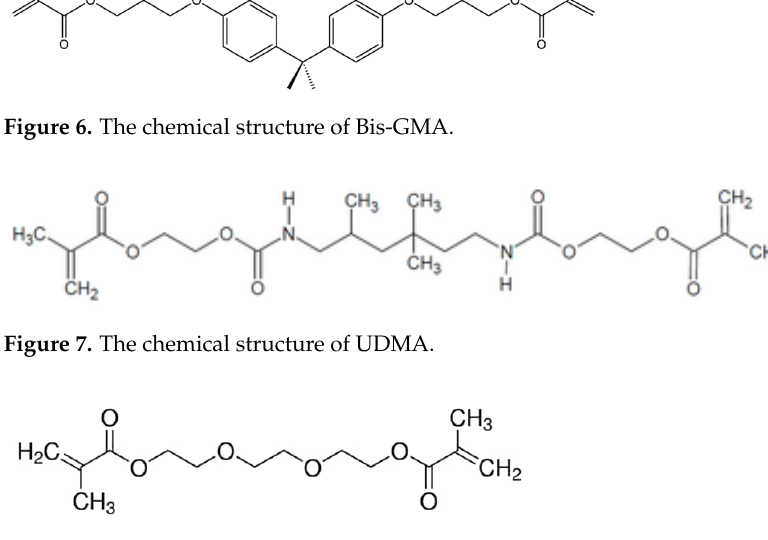
Figure 8. The chemical structure of TEGDMA.